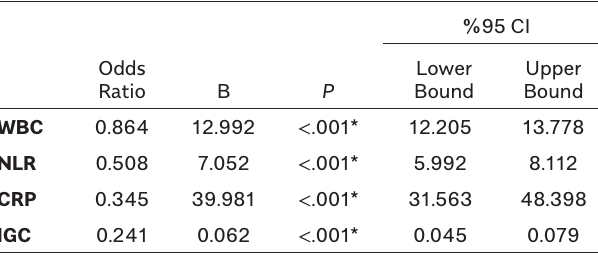
Table 3. Multivariate Analyses Results of İ nflammatory Markers for Prediction of Acute Appendicitis for Clinically Suspected Cases According to ASS